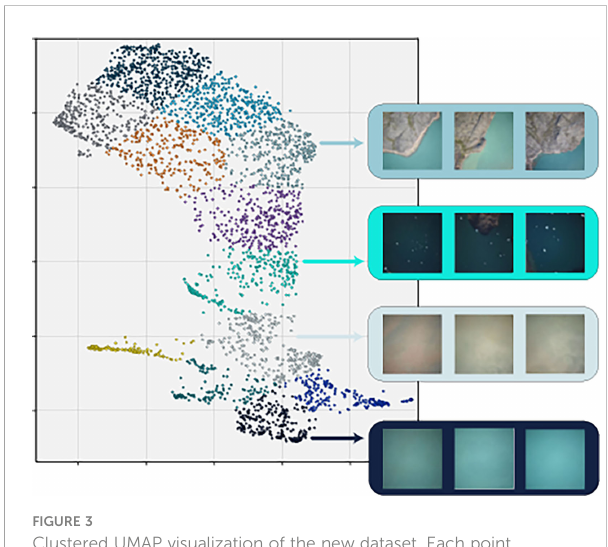
FIGURE 3 Clustered UMAP visualization of the new dataset. Each point represents an image and is color-coded by cluster. To illustrate the similarity of images within clusters, rectangles on the right show examples of three random images from four different